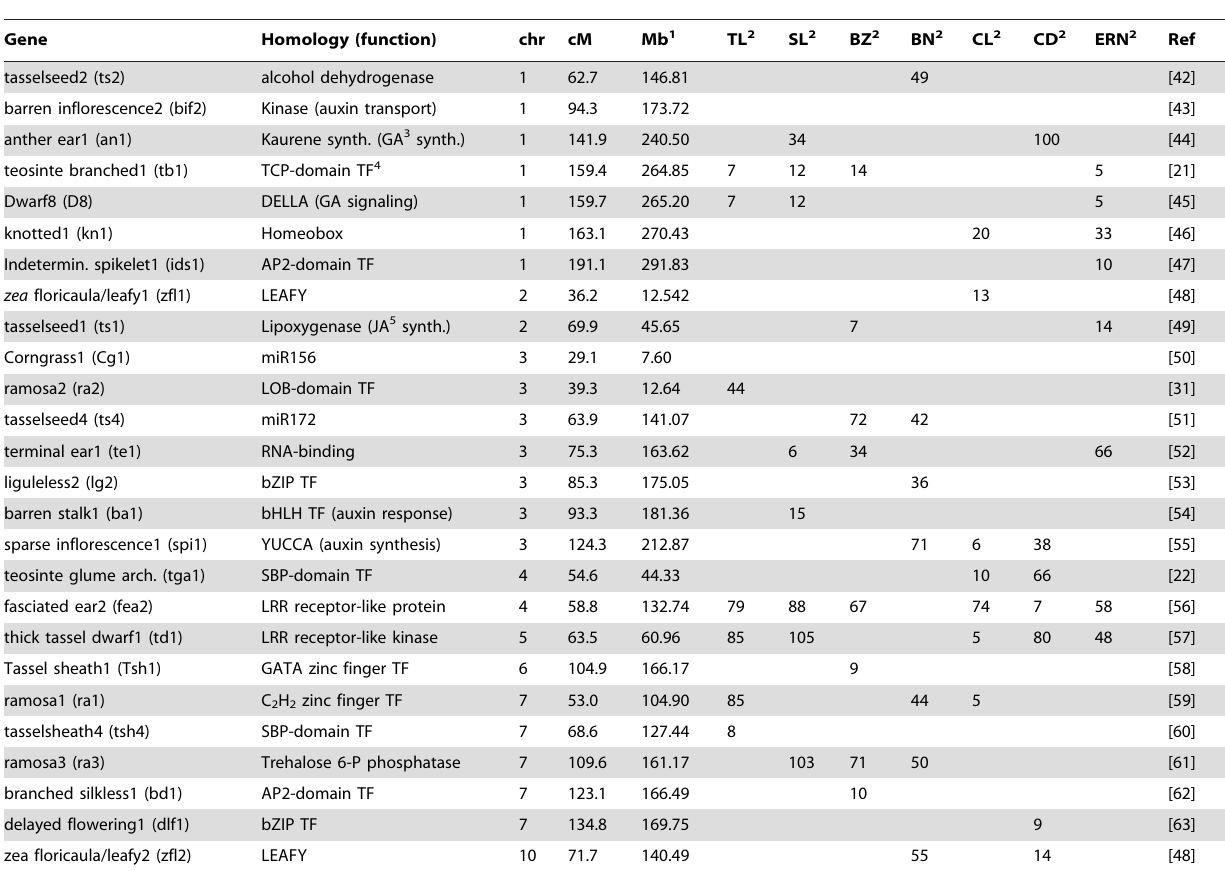
Table 3. Cloned maize mutants with inflorescence phenotypes and their co-localization with GWAS SNPs.